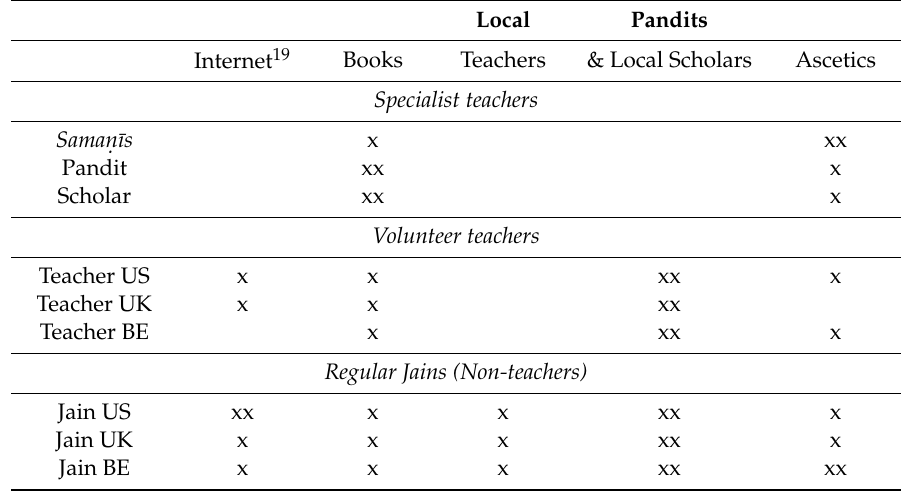
Table 1. Strategies for obtaining doctrinal information used by di ff erent actors in the Jain